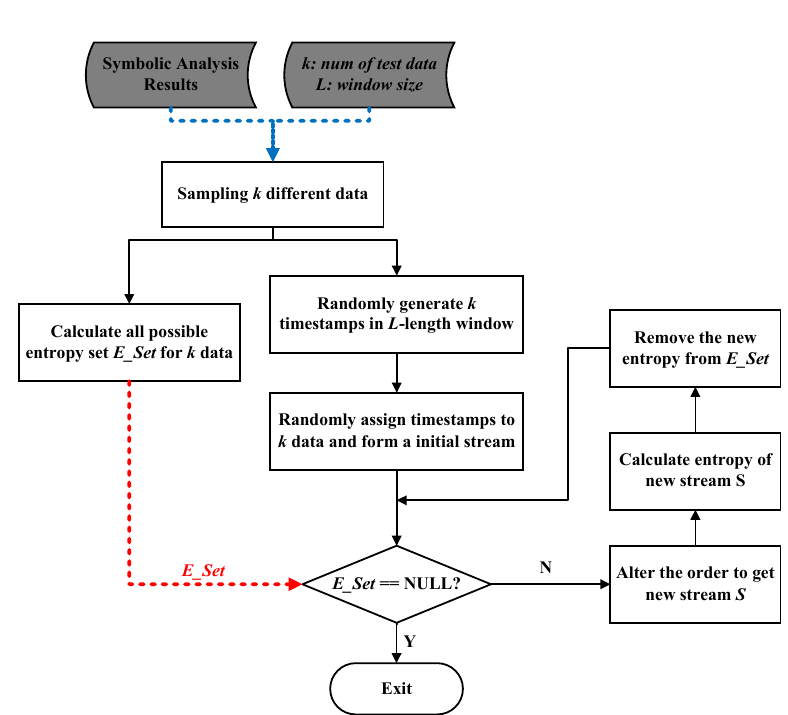
Figure 6. The iterative process to generate